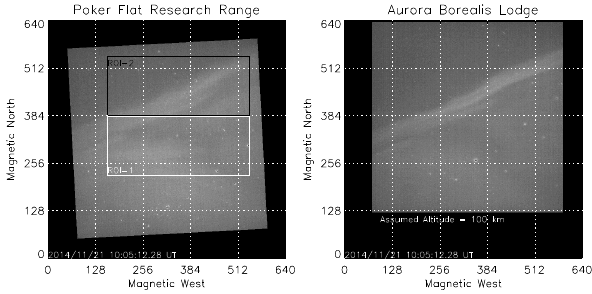
Figure 2. Example images of comparison. ROI-1 and ROI-2 are marked by white and black squares,